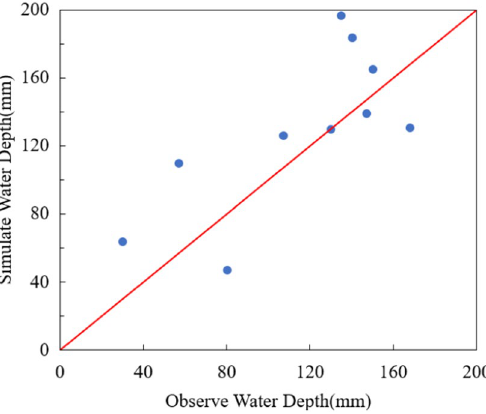
Figure 6. Comparison of observed and simulated water depth. This graph was generated with OriginPro 2021 (Learning Edition)(https:// www. origi nlab. com/).